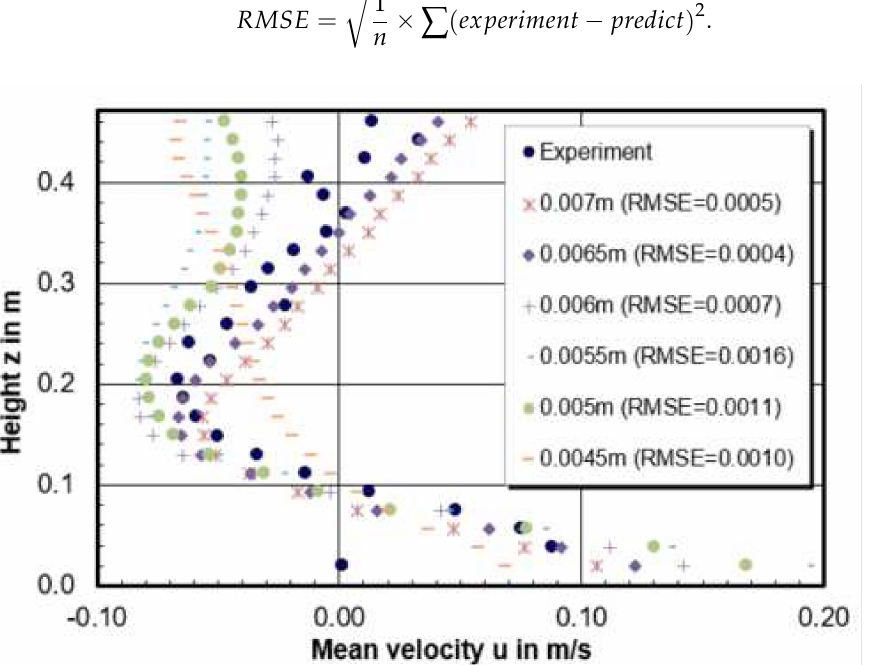
Figure 5. Horizontal velocity (u) through the recirculation center of CFD models with mesh size of ( a ) 0.0045 m, ( b ) 0.005 m, ( c ) 0.0055 m, ( d ) 0.006 m, ( e ) 0.0065 m, ( f ) 0.007